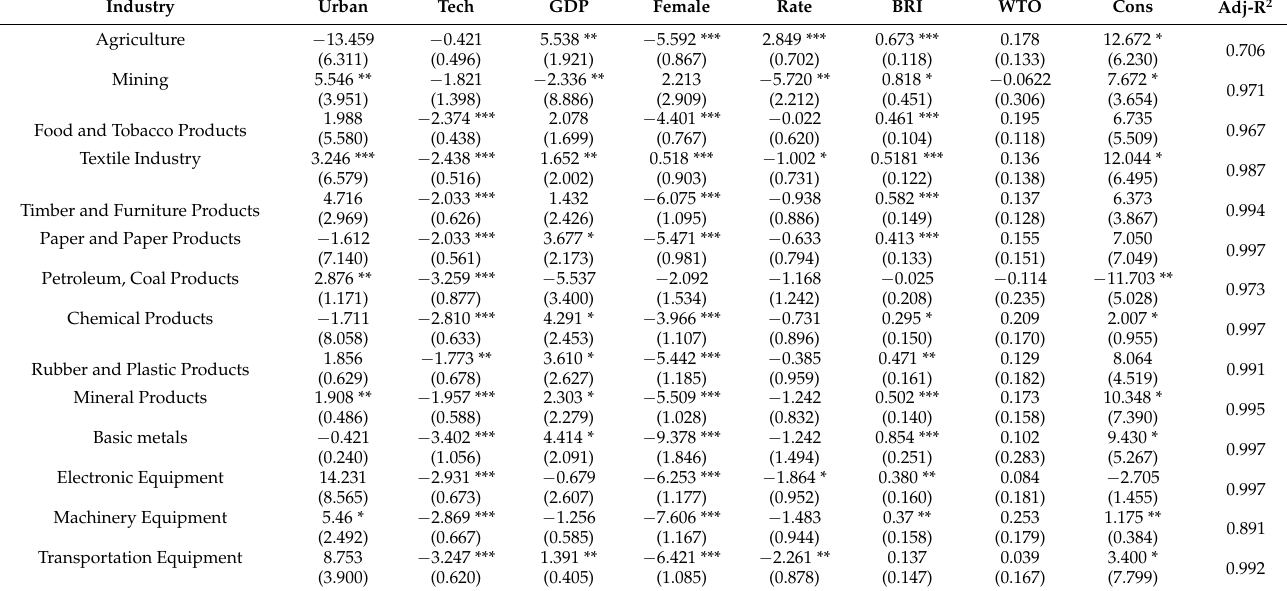
Table 4. The FMOLS regression results by industry.